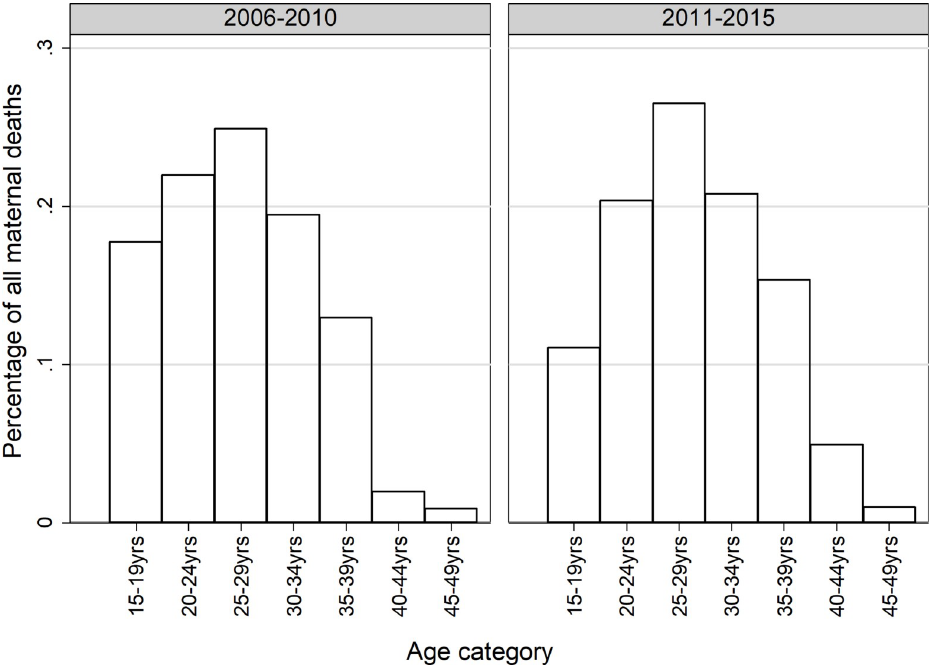
Fig 3. Proportion of all maternal related deaths by age comparison between 2006–2010 and 2011–2015 (2006– 2010: n = 755; 2011–2015:n = 1,235).